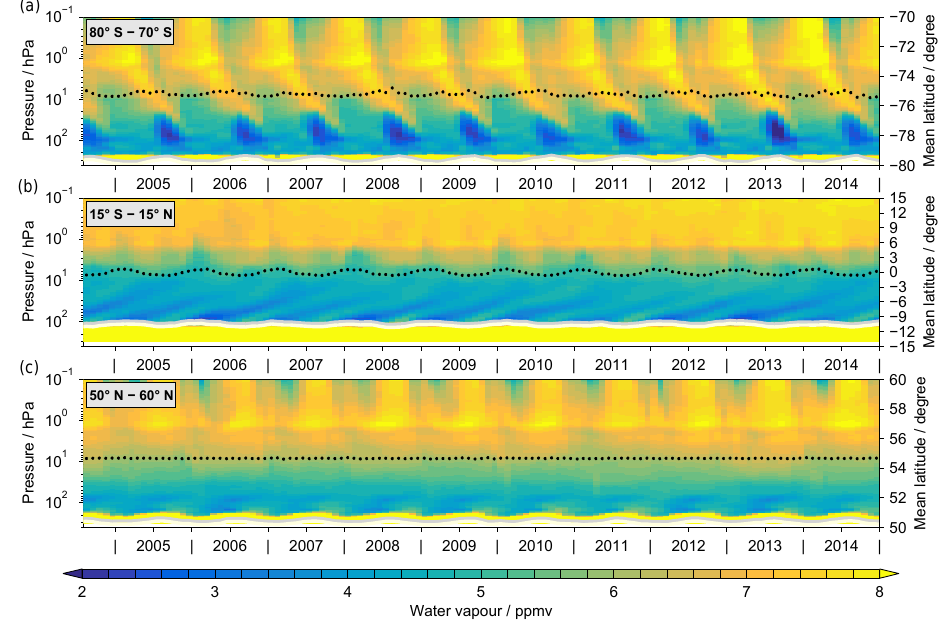
Figure 1. Water vapour time series for the latitude bands 80 ◦ to 70 ◦ S (a) , 15 ◦ S to 15 ◦ N (b) and 50 ◦ to 60 ◦ N (c) based on the MLS data. The light grey and white lines indicate the tropopause as derived from the MERRA reanalysis data. The black dots and the corresponding y axes on the right show the average latitude of the monthly mean data. White areas indicate that there are no